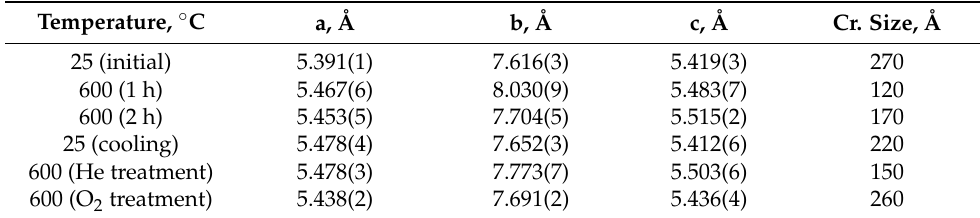
Table 2. Lattice parameters and the degree of crystallinity for La 0.5 Ca 0.5 Mn 0.5 Co 0.5 O 3 . Temperature, ◦ C a, Å b, Å c,